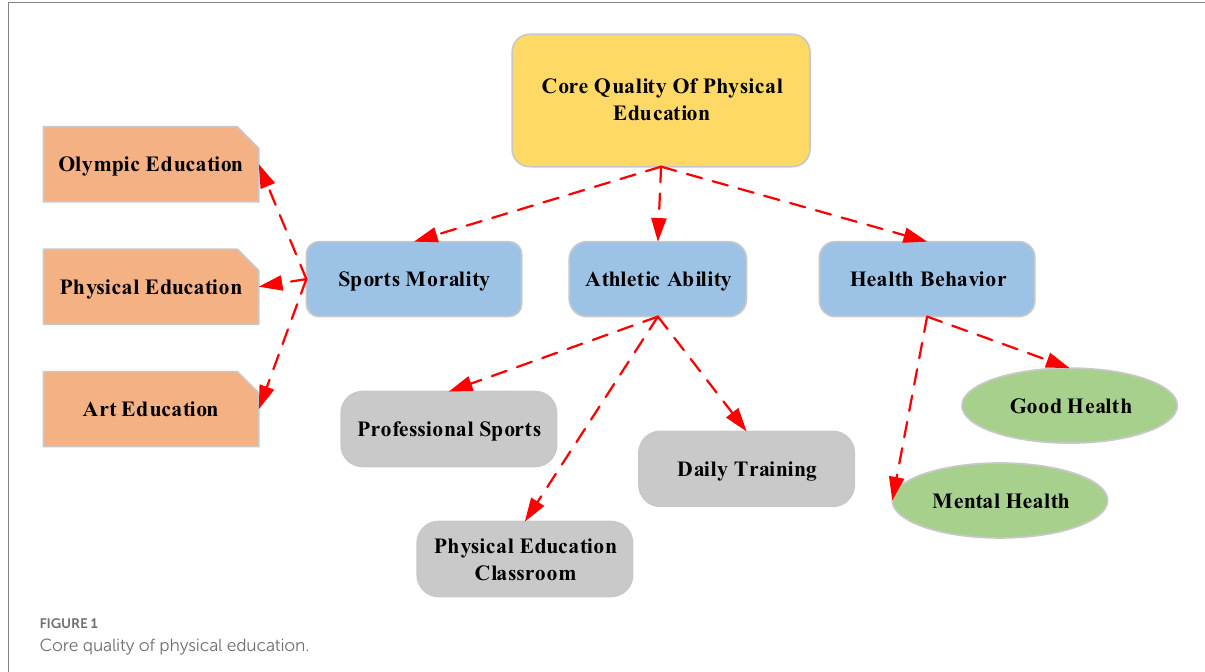
FIGURE 1 Core quality of physical